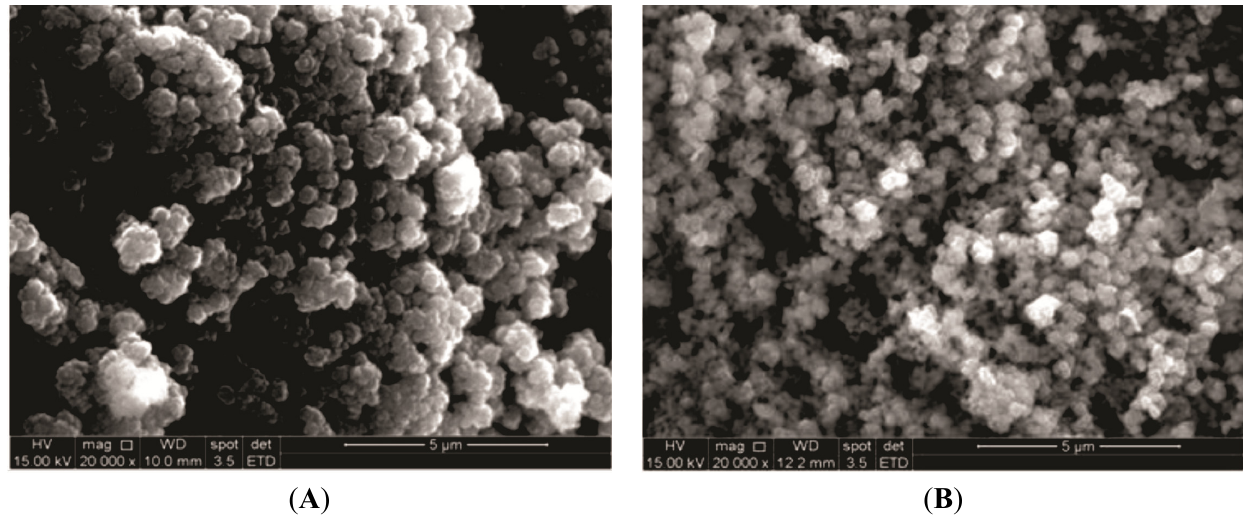
Figure 9. Typical SEM images of bioceramic powders: Nb-HA_110 ( A ) and Nb-HA_900 ( B